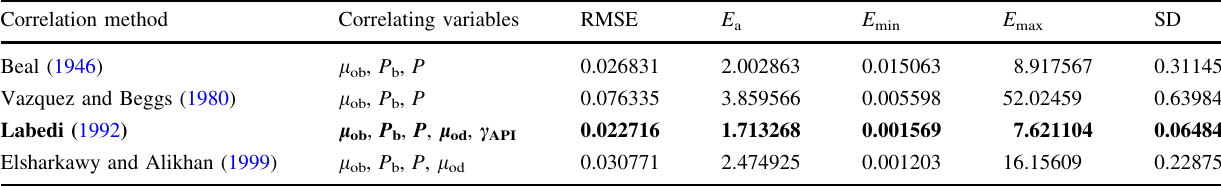
Table 10 Performance of l oa empirical